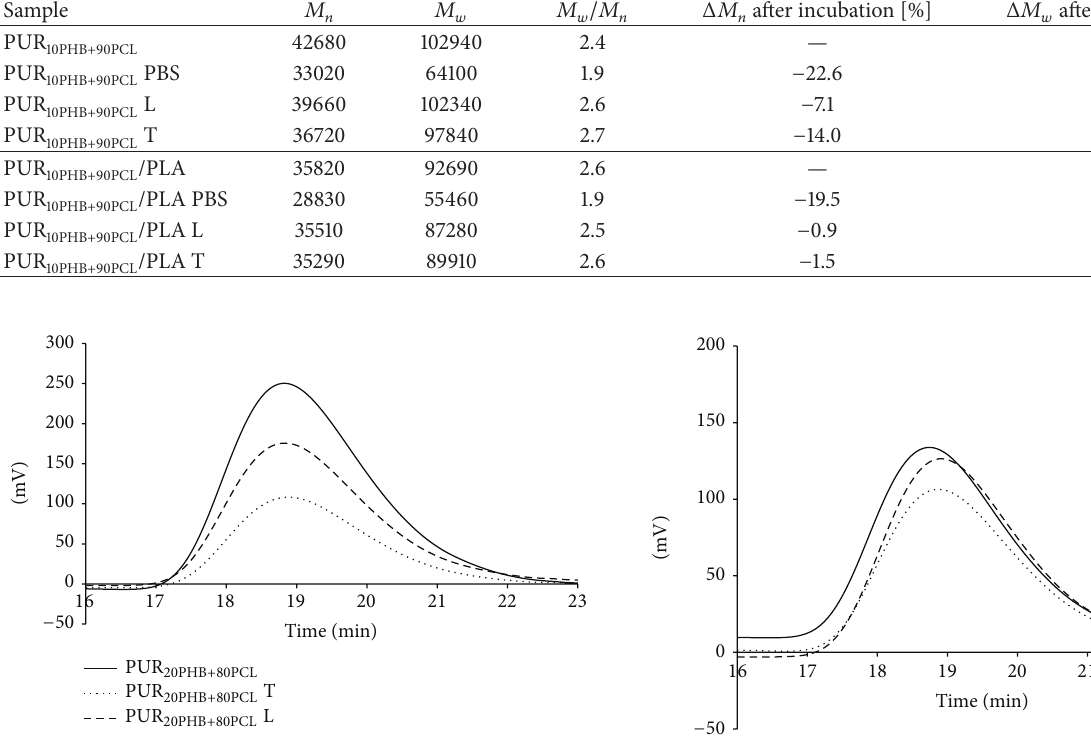
Figure 3: SEC traces of PUR 20PHB + 80PCL before (PUR 20PHB + 80PCL ) and after incubation in trypsin (PUR 20PHB + 80PCL T) and in lipase (PUR 20PHB + 80PCL L).